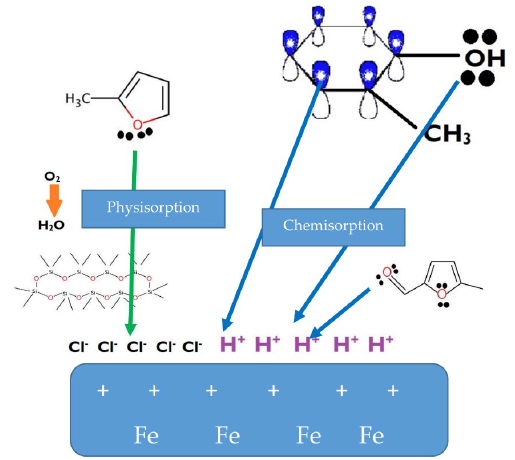
Figure 7. The schematic of the inhibition mechanism of inhibitors. The successful collision between the adsorbed inhibitor and Fe 2+ /Fe 3+ particles in- creases the number of the larger diameter of particles after the addition of the inhibitor, suggesting the growth of passive film, which is evident in treated mild steel (Figure 6d). Based on the above evidence, the chemical and physical interactions can enhance RHA’s anti-corrosion. The availability of unpaired p-electrons on the inhibitor’s oxygen (hydroxyl) and nitrogen (amine) atoms increases the feasibility of forming a dative cova- lent bond (chemical bonding) between the d-orbital of iron and the inhibitor molecules through the chemisorption adsorption process. Moreover, the delocalization electrons on the benzene ring form a similar bond with a 3D vacant orbital of Fe over the surface of carbon steel [72]. Accordingly, it is possible to presume that the physical interaction occurred between the anion of chloride ions and protonated Lewis base of nitrogen. Similar to Ber- dimurodov [73], the excess hydrogen ions of HCl are diminished by the reaction with the hydroxyl functional groups from the active compound of RHA. The result of the Tafel plot related to anodic and cathodic branches confirms the pair of bonds (physically and chem- ically) (see Table 1). Therefore, it may be concluded that the LS smoke of RHA mitigates the corrosion of C1018 by adsorbing homogeneously and forming a passive film by repel- ling more water molecules.